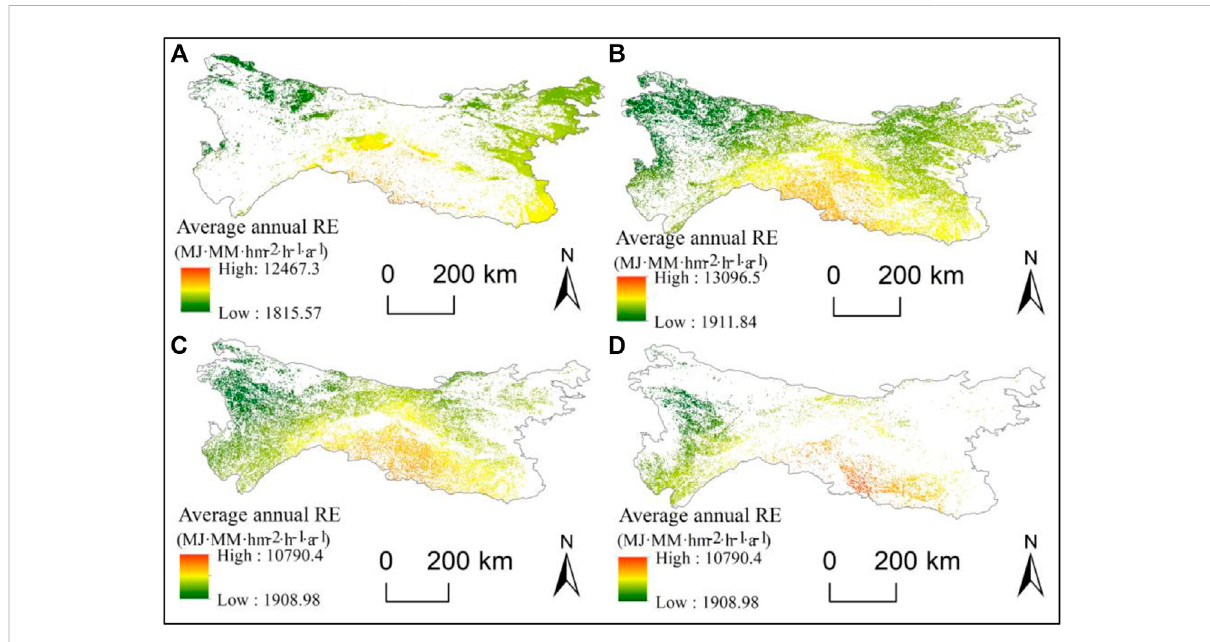
FIGURE 11 Spatial distribution of average annual rainfall erosivity over micro-topography (A) , small topography (B) , medium topography (C) , and large topography (D) .